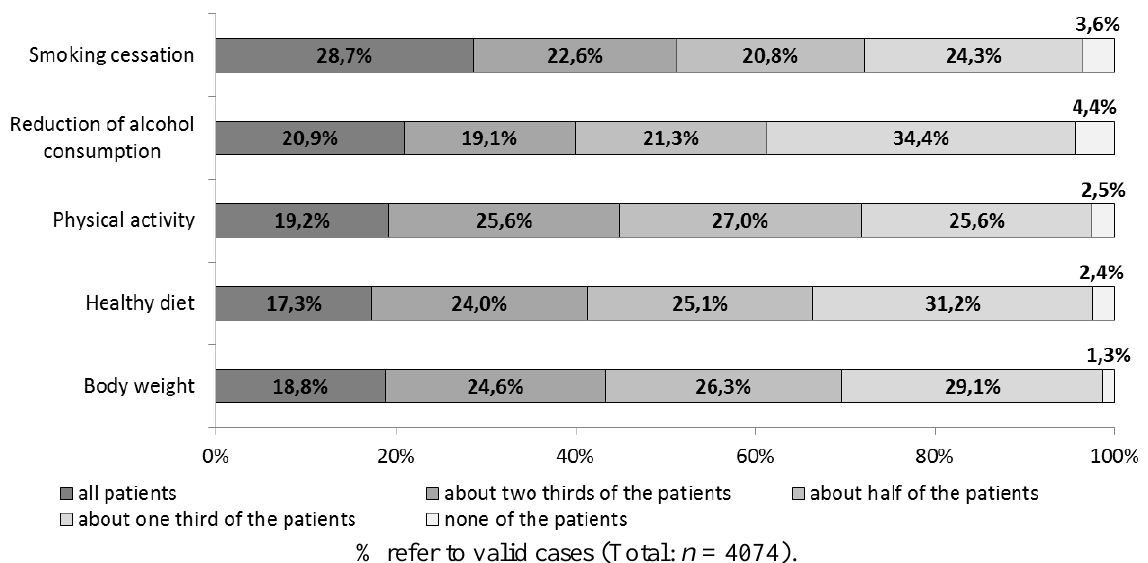
Figure 1. Provision of lifestyle-based intervention measures in a primary care setting, Germany (% of PCPs).